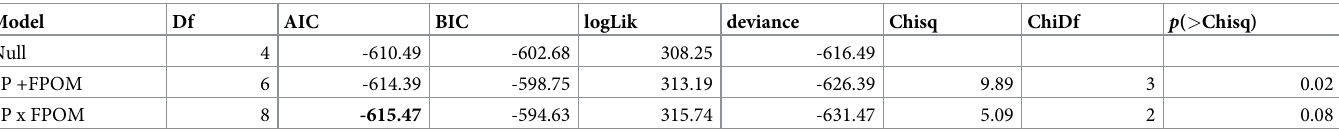
Table 5. LMM performances of growth rates of Andesiops peruvianus and Anomalocosmoecus illiesi with mean FPOM as fixed factors and chamber as a random fac- tor. Species [SP] was added as a covariate. The models tested were the null model, SP+FPOM without interaction, and SP x FPOM with single and interaction effects. The AIC best model is in